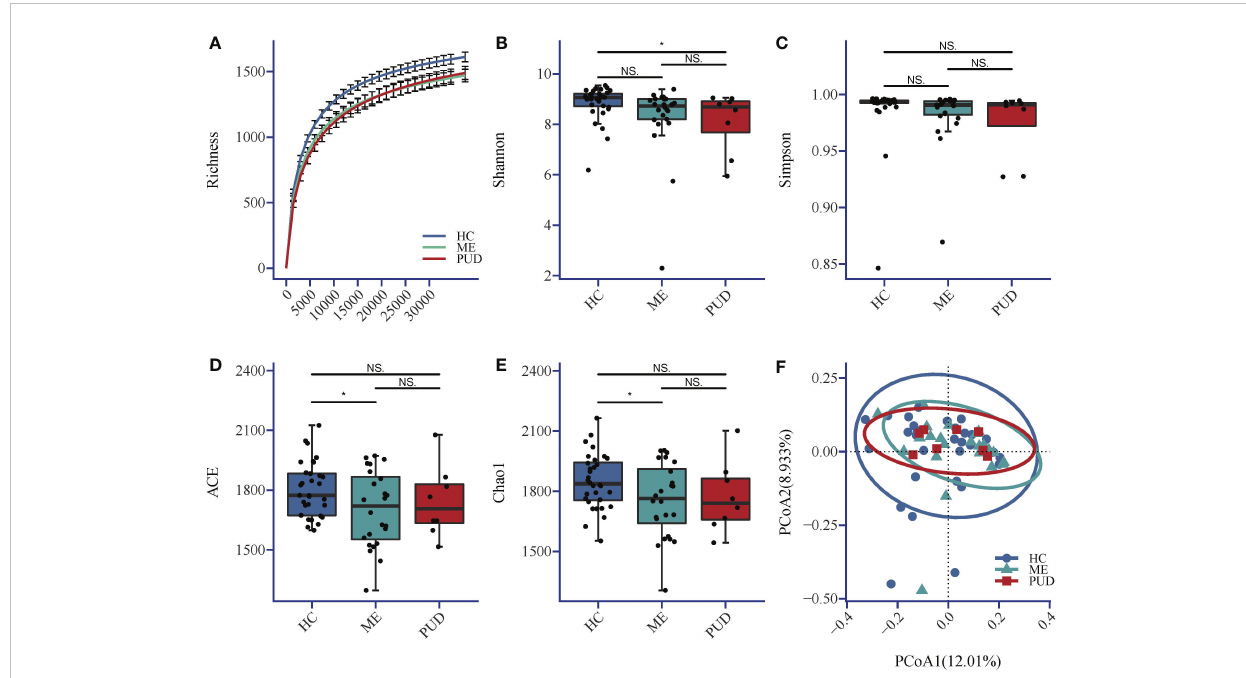
FIGURE 1 (A) Richness; (B) Shannon index; (C) Simpson index; (D) ACE index; (E) Chao1 index; (F) Beta diversity. Alpha diversity index and Beta diversity. *, a signi fi cant difference between the two groups (P<0.05); NS, no signi fi cant difference between the two groups (same below). The horizontal line in the box plot is the mean and the error bars are the standard